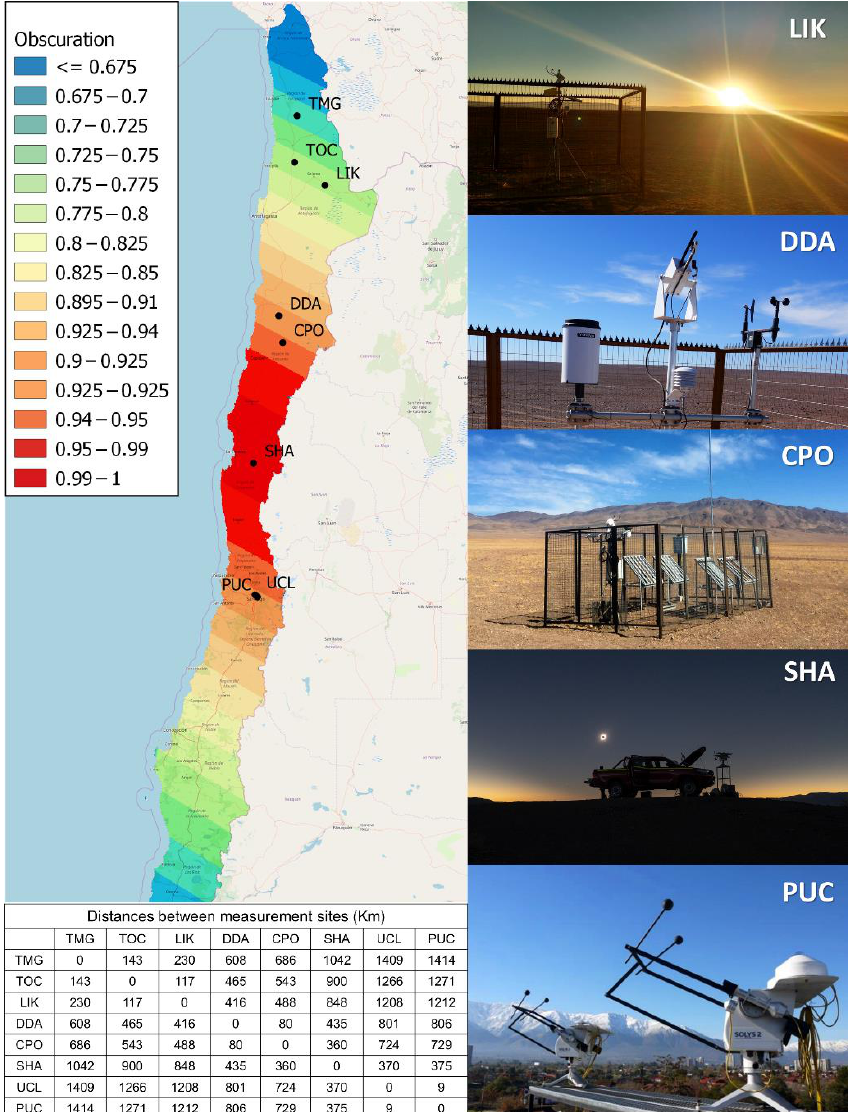
Figure 3. Station locations and maximum obscurations throughout Chilean territory, along with distances across measurement stations.